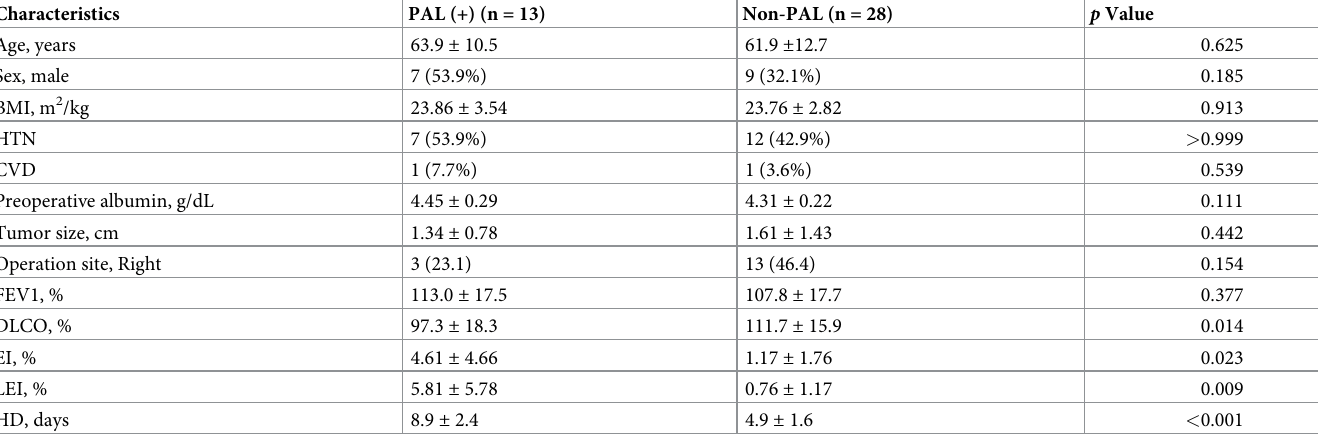
Table 1. Baseline characteristics according to the prolonged air-leak.